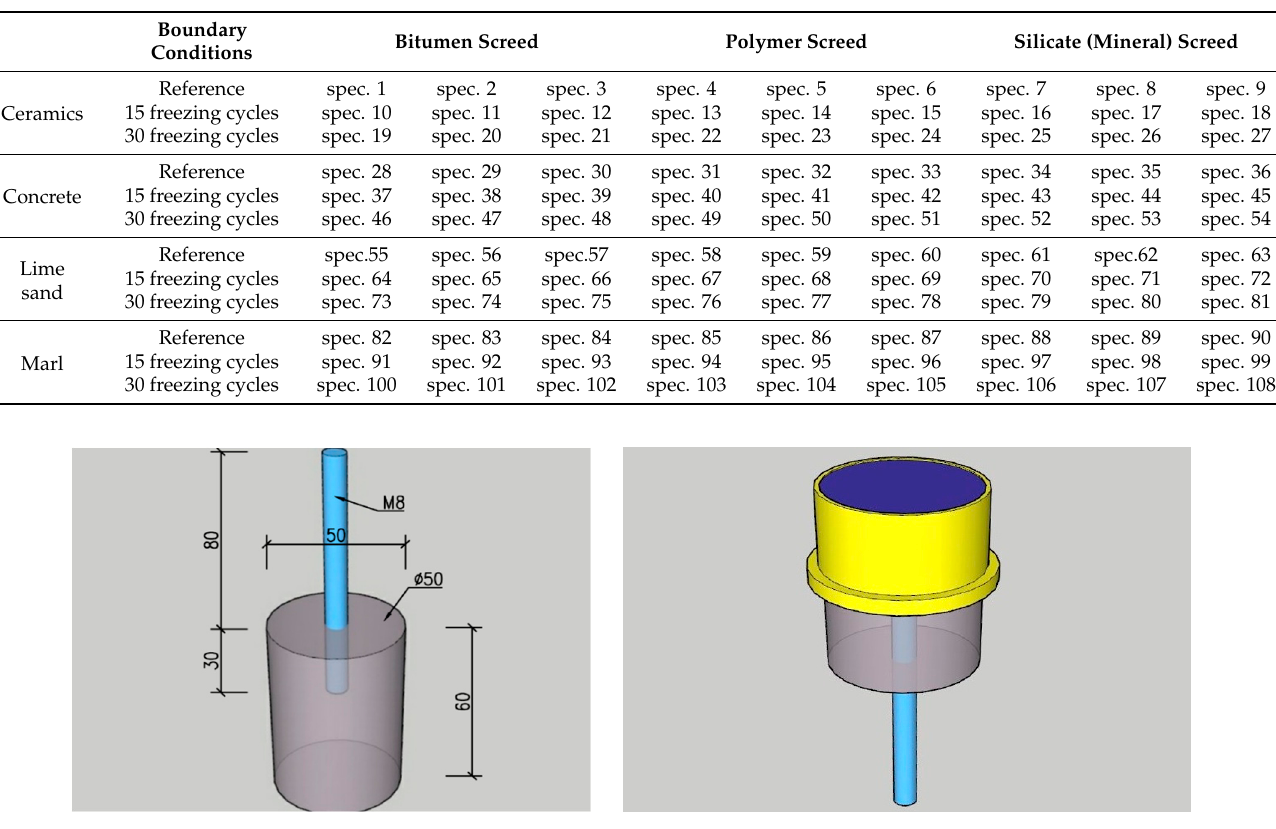
Table 1. Total set of specimens. Figure 4. Water pressure test on the sets of specimens.